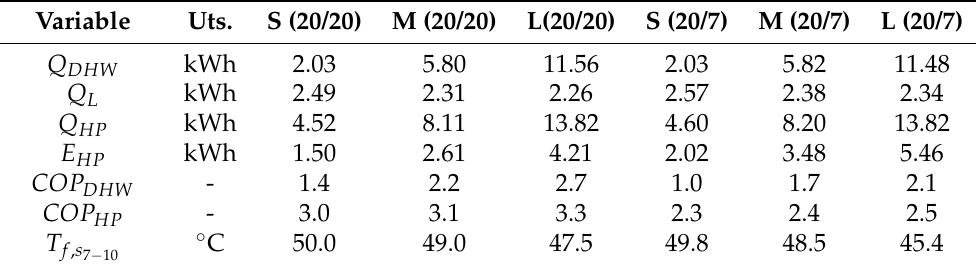
Table 5. EN 16147 simulated results of reference tapping cycles from S, M, and L. Energy and performance results for an ambient temperature of 20 ◦ C and inlet air temperatures to the evaporator of 7 ◦ C and 20 ◦